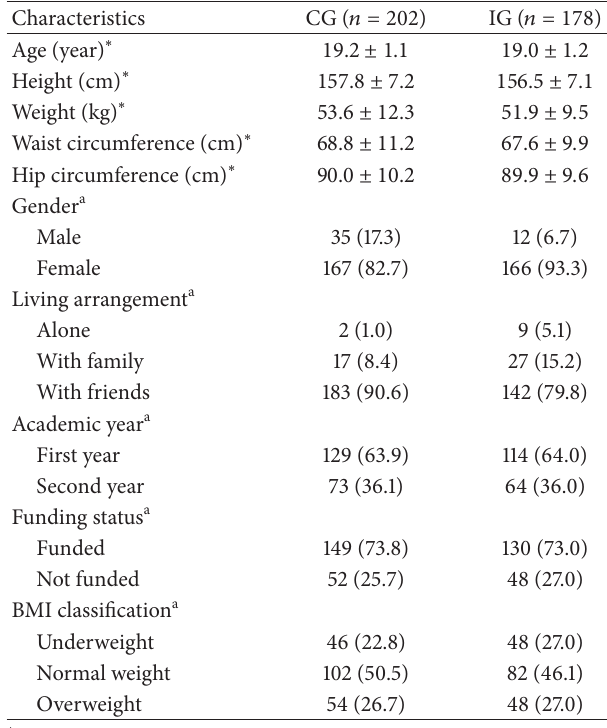
Table 2: Selected characteristics of study